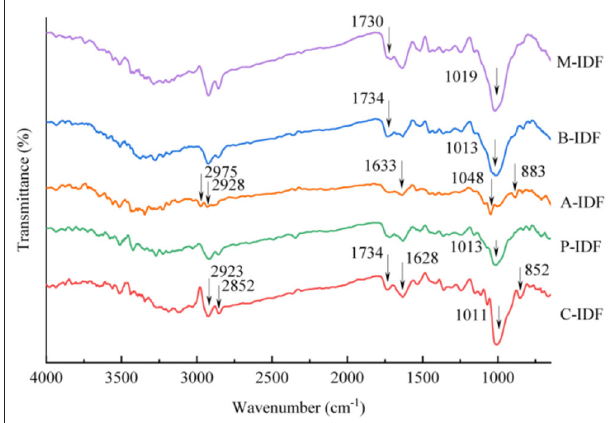
FIGURE 1 | FT-IR spectra of wheat bran insoluble dietary fiber (W-IDF) modified with different microbial. C-IDF, W-IDF without microbial modification; P-IDF, W-IDF modified by L. plantarum ; A-IDF, W-IDF modified by L. acidophilus ; B-IDF, W-IDF modified by B. subtilis . M-IDF, W-IDF modified by mixed lactic acid bacteria ( L. acidophilus: L. plantarum =